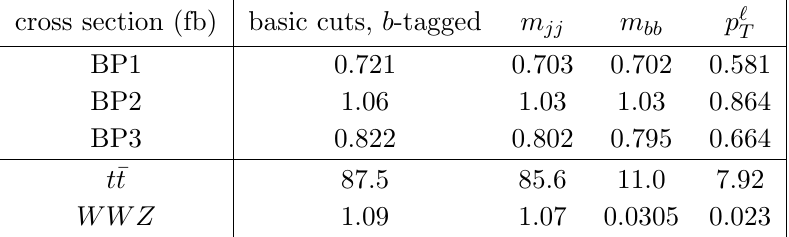
Table 2 . Cut (cid:13)ow of signal and background cross sections in the jj‘ (cid:6) bb channel. Here the combined decay branching